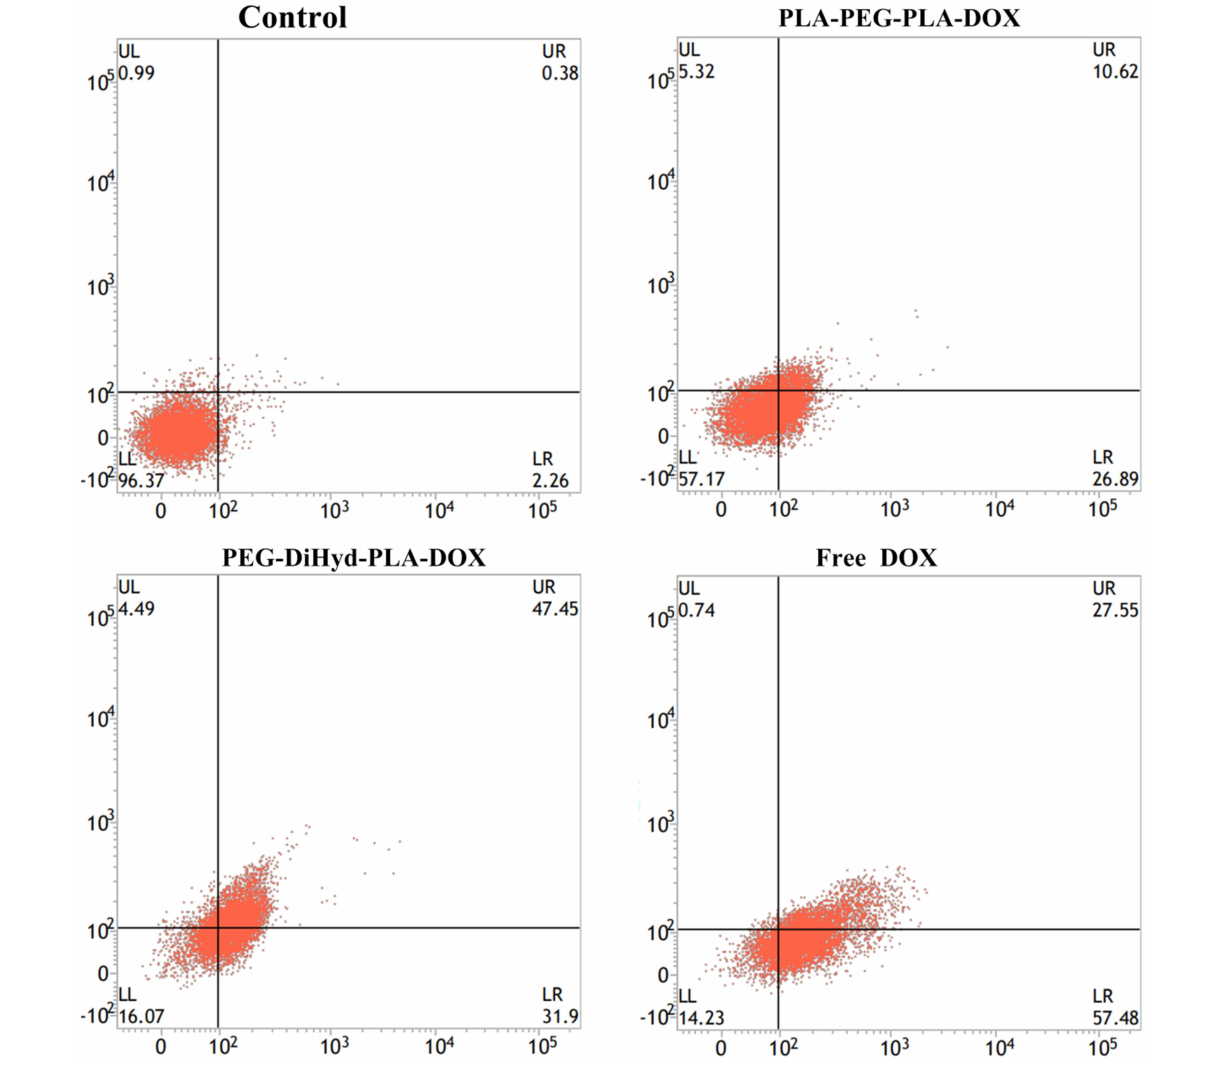
FIGURE 10 | Apoptotic cell populations determined by flow cytometric analysis with Annexin V-FITC and PI staining after incubating HepG-2 cells for 48h, DOX equivalent concentration was 10 µ g/mL. The lower-left and upper-left quadrants in each panel indicate the populations of normal cells and necrotic cells, respectively. While the lower-right and upper-right quadrants in each panel indicate the populations of early and late apoptotic cells,